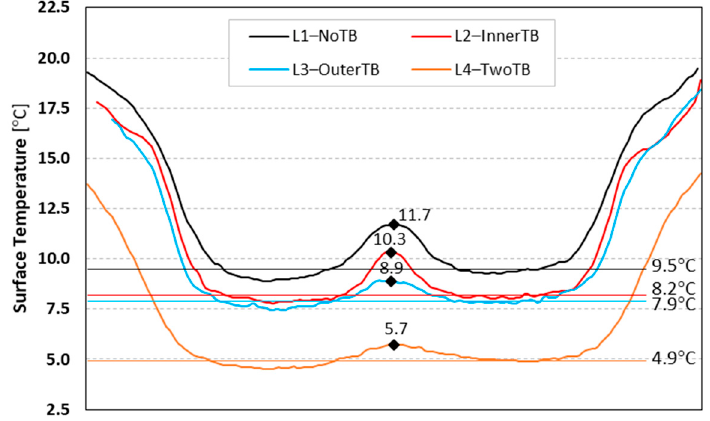
Figure 7. Infrared thermography photos of the LSF partition walls: cold side.